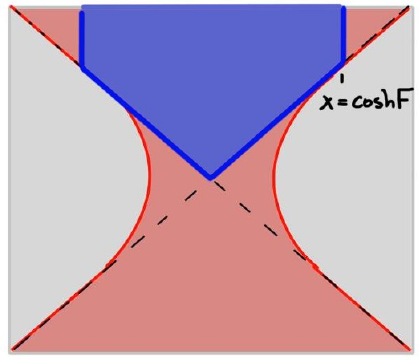
Figure 6 . The blue shaded region is the portion of the black hole interior that is included in the late-time entanglement wedge of any subsystem j x j > a for any a , of the radiation system (for Poincar(cid:19)e